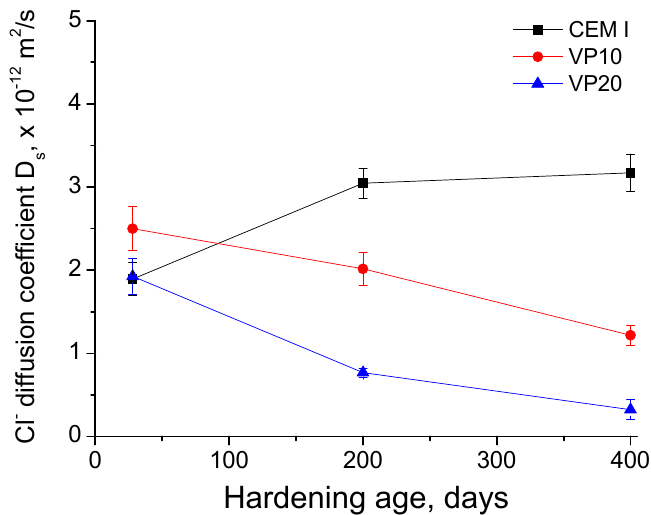
Figure 14. Results of the steady-state chloride diffusion coefficient obtained for the mortars studied.